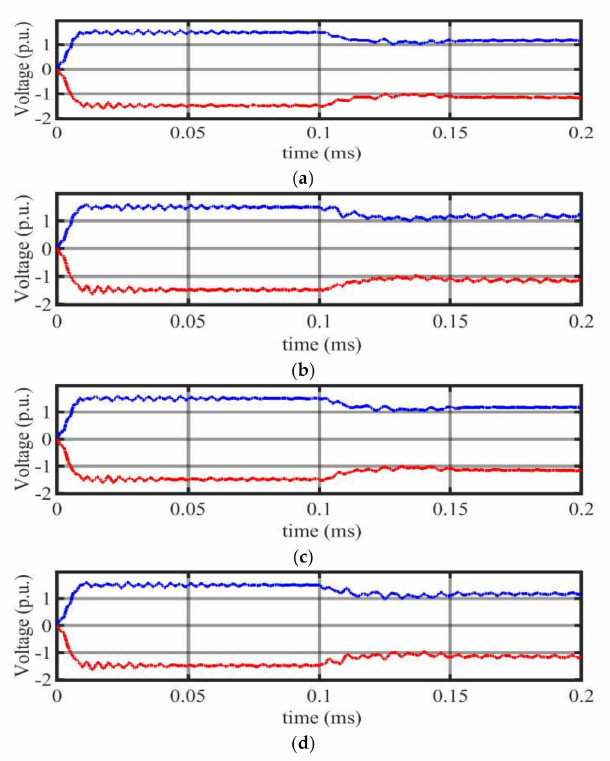
Figure 12. DC voltages measured at ( a ) RS-I, ( b ) IS-I, ( c ) RS-II, and ( d ) IS-II under normal